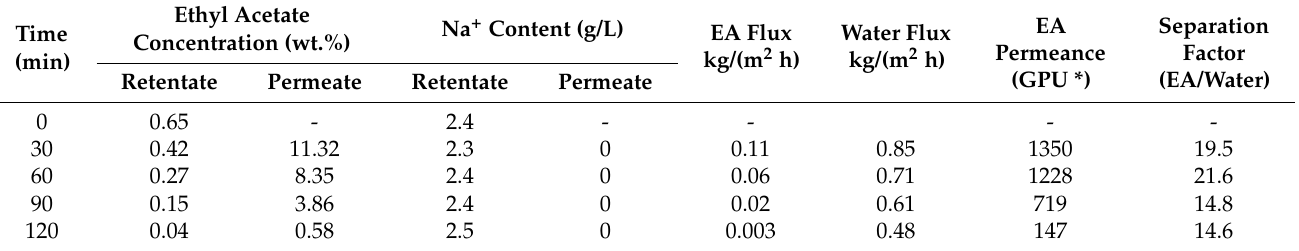
Table 6. Variation in the main components during the pervaporation process.